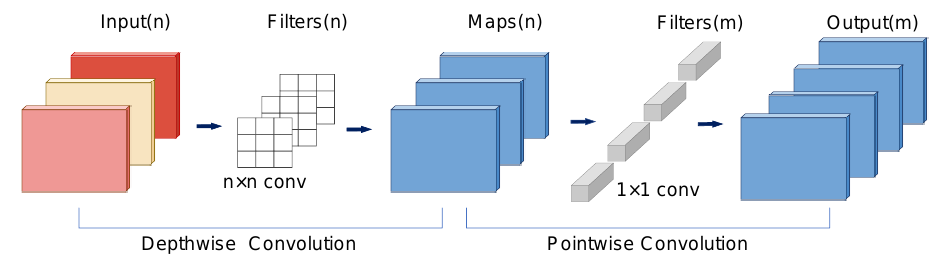
Figure 10. Depthwise separable convolution, including depthwise convolution (DW) and pointwise convolution (PW).